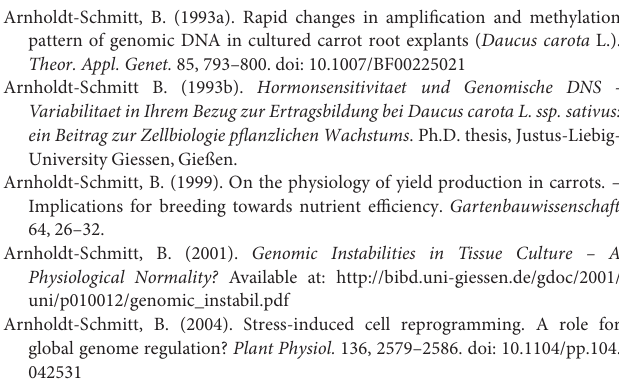
FIGURE S1 | (A) Growth curve of primary cultures system of D. carota L. cv. Rotin during 28 days in culture at 21 ◦ C in four individual plants. Data are shown as callus FW values and represented as mean ± SD. (B) Explants from the secondary phloem of carrot tap roots PCS. Aspect of the explants (1) before (T0), (2) 14 days, and (3) 28 days after in vitro